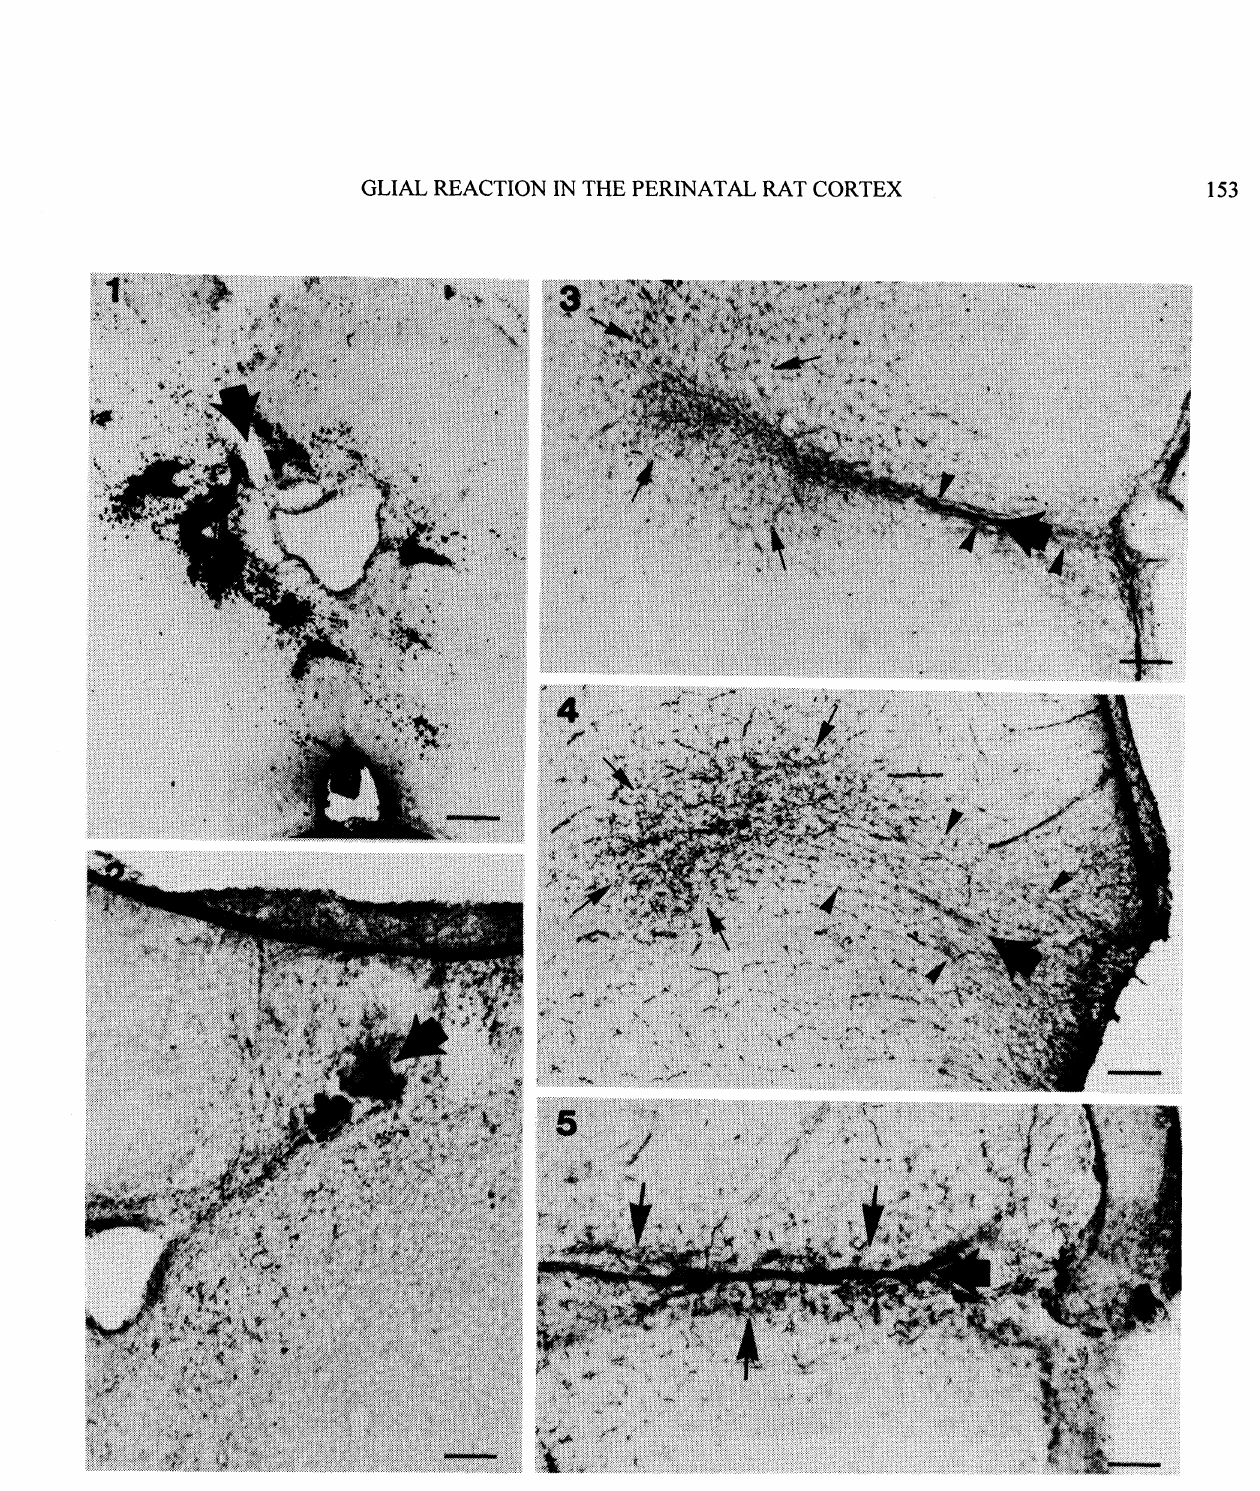
Figs. 1-5: GFAP immunostaining of glial reactions following P0 lesions. (1) Severe-type P0 lesion, postoperative (post-op) day 4 (d-4). Lesion site (thick arrows) is marked by tissue destruction and bleeding. No reactive glia are seen. Bar 200 tm. (2) Severe-type P0 lesion, post-op d-6. Bleeding and tissue defect (thick arrows) but no reactive glia are seen. Bar 200 m. (3) Severe-type P0 lesion, post-op d-7. Weak glial reaction detected (arrows) around the deeper part of the lesion (thick arrow), the superficial part (arrowheads), however, is not surrounded by reactive glia. Bar 150 tm. (4) Severe-type P0 lesion, post-op d-8. In the depth of the cortex the glial reaction (arrows) around the lesion (thick arrow) is stronger, than that shown in Fig. 4, but there is no reactive glia in the superficial region (arrowheads). Bar 150 lam. (5) Severe- type P0 lesion, post-op d-10, GFAP immunostaining. The superficial part of the lesion (thick arrow) has also been surrounded by reactive astrocytes (arrows). Bar 150